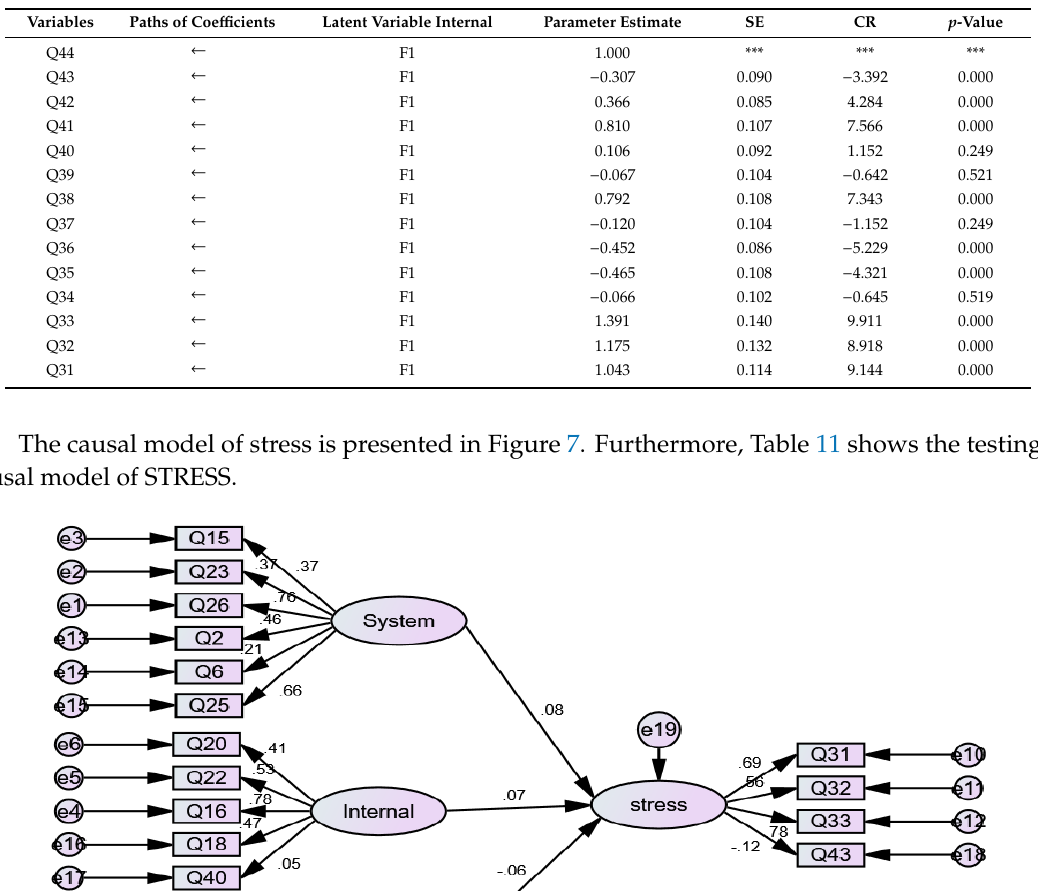
Table 10. Confirmatory factor analysis of STRESS.